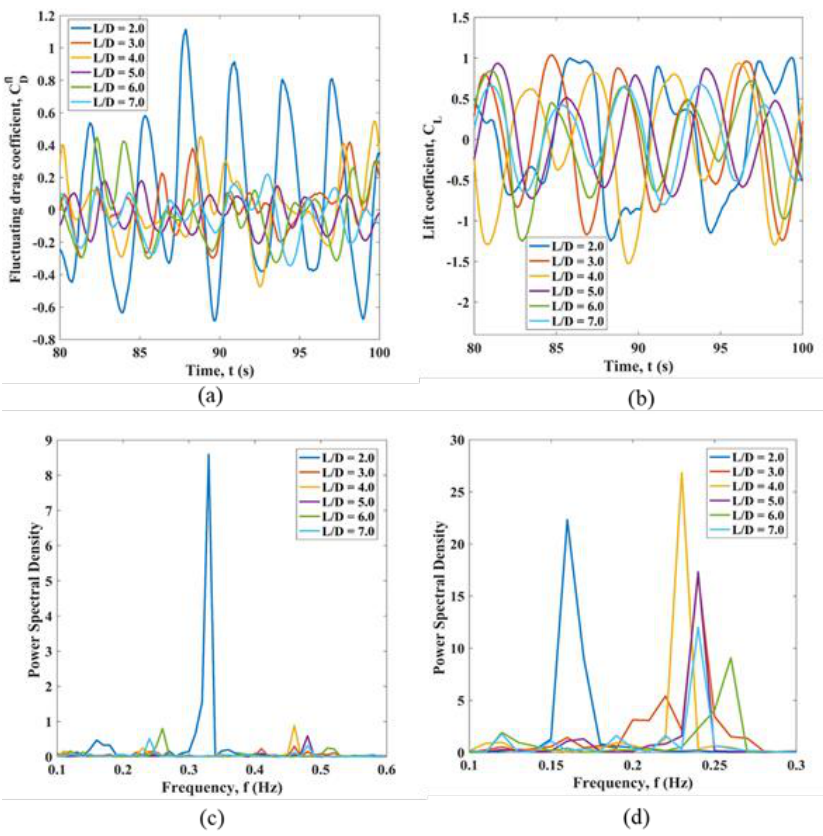
Figure A1. Fluid force coefficients for cylinder 2 immersed in the uniform flow: ( a ) time history of the fluctuating drag coefficient; ( b ) time history of the lift coefficient; ( c ) the drag coefficient FFT; ( d ) the lift coefficient FFT.